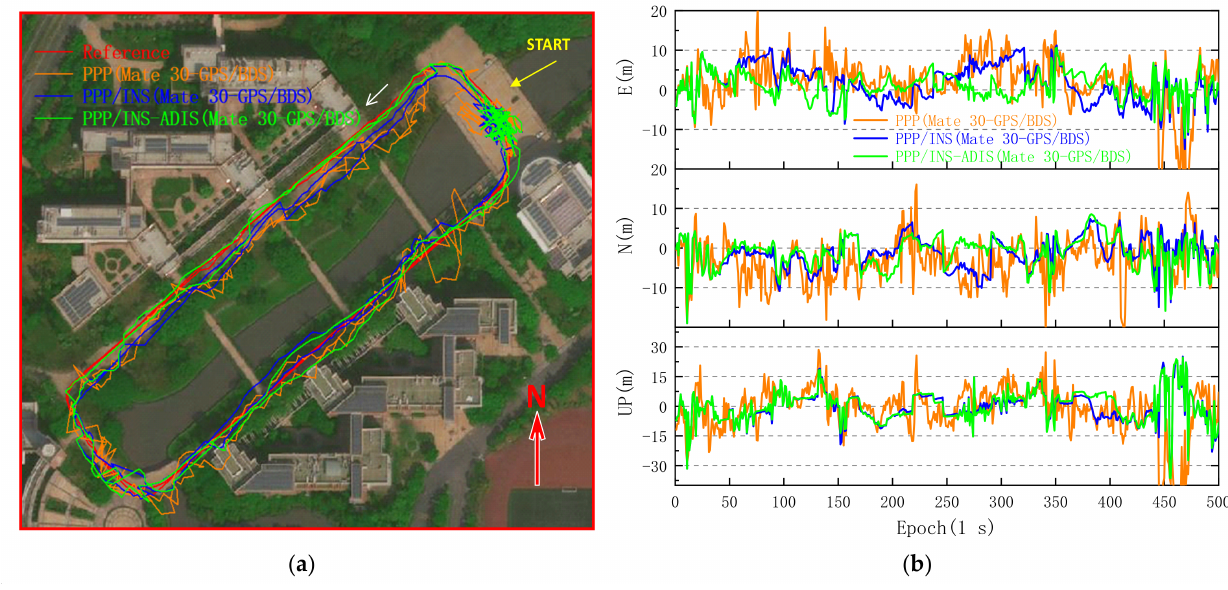
Figure 14. GPS/BDS PPP and PPP/INS solutions from Huawei Mate 30 on the sidewalk. ( a ) Trajec- tories of GPS/BDS PPP and PPP/INS solutions. ( b ) Comparison of GPS/BDS PPP, PPP/INS, and PPP/INS–ADIS solutions with reference points. PPP/INS–ADIS denotes that the data of ADIS16405 were used in the PPP/INS coupled model instead of the IMU data of